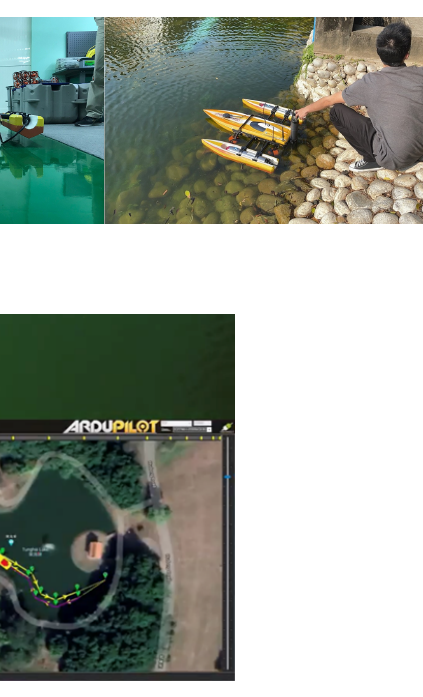
Figure 11. Water Quality Data